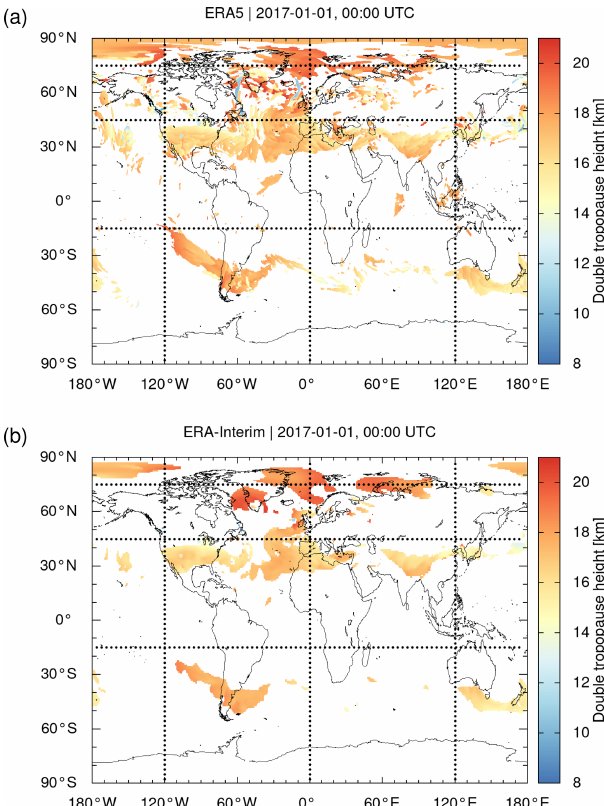
Figure 7. Global maps of (a) ERA5 and (b) ERA-Interim double- tropopause geopotential heights on 1 January 2017, 00:00UTC. The data are sampled on a 0 . 3 ◦ × 0 . 3 ◦ horizontal grid. White color in- dicates areas where no double tropopause was detected. Note that high-latitude polar winter detections are related to isothermal tem- perature conditions and the influence of the polar vortex. Meridional and zonal cross sections along the dotted lines are shown in Figs. 3 and 4,